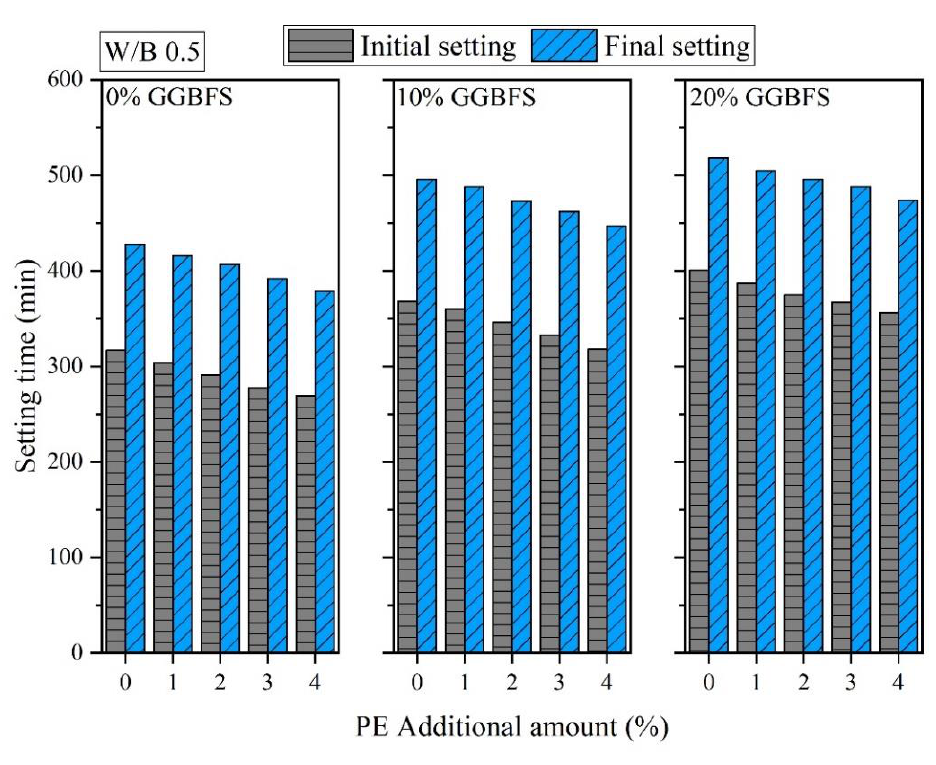
Figure 5. Setting time of cement mortars with the addition of different ratios of waste PE and GGBFS replacement.